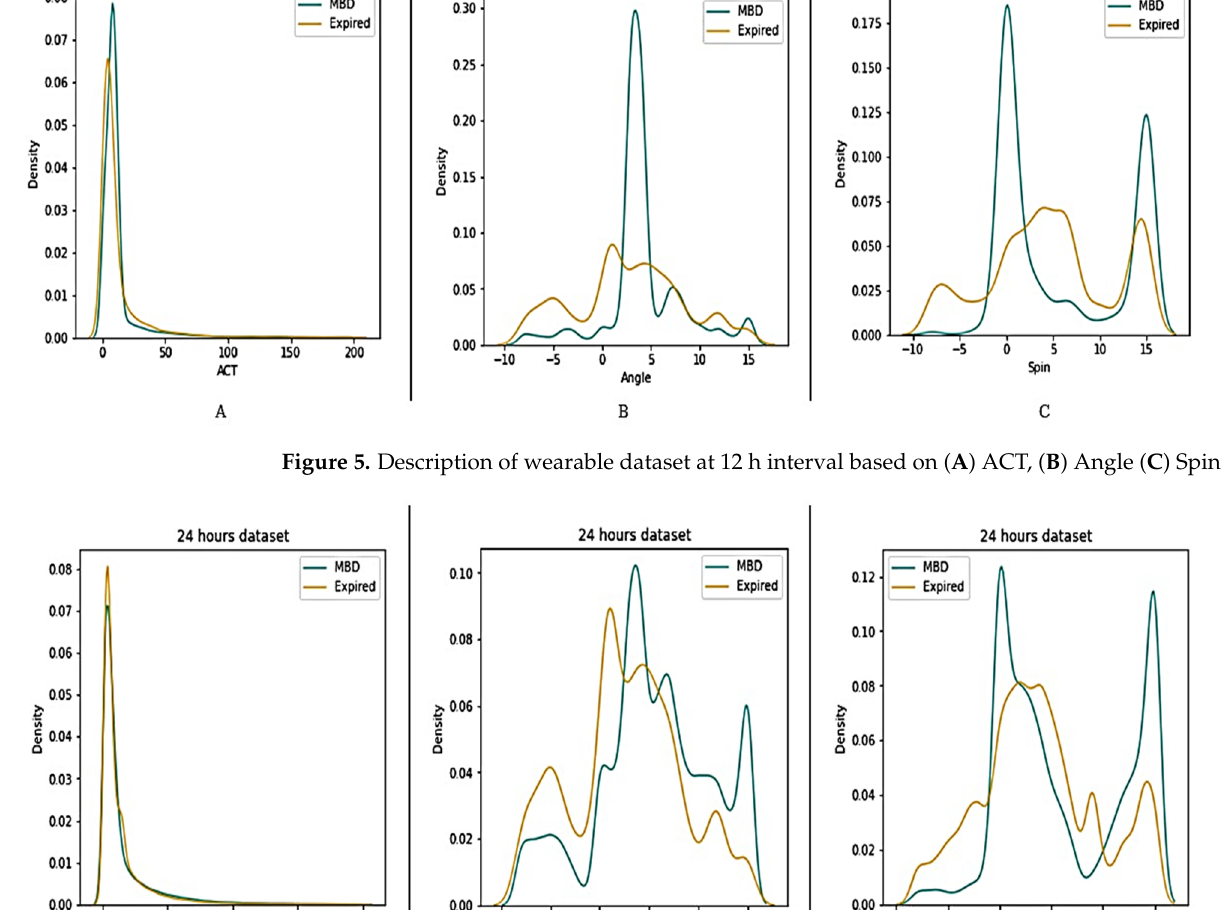
Figure 4. Correlation of clinical information with survival outcomes.